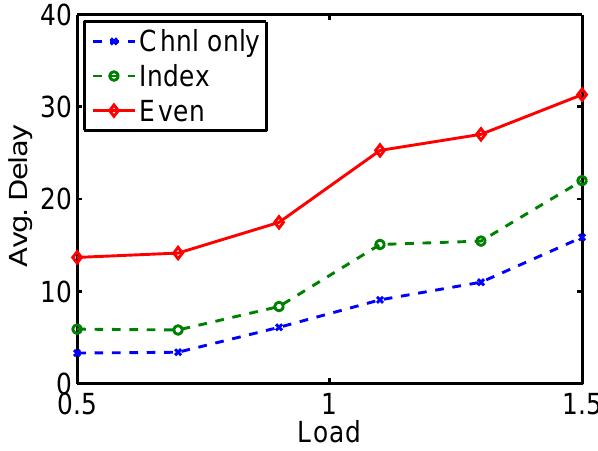
Figure 9. Average Delay when Index Policy Objective is Minimizing Missed Deadlines, Real-life Trace